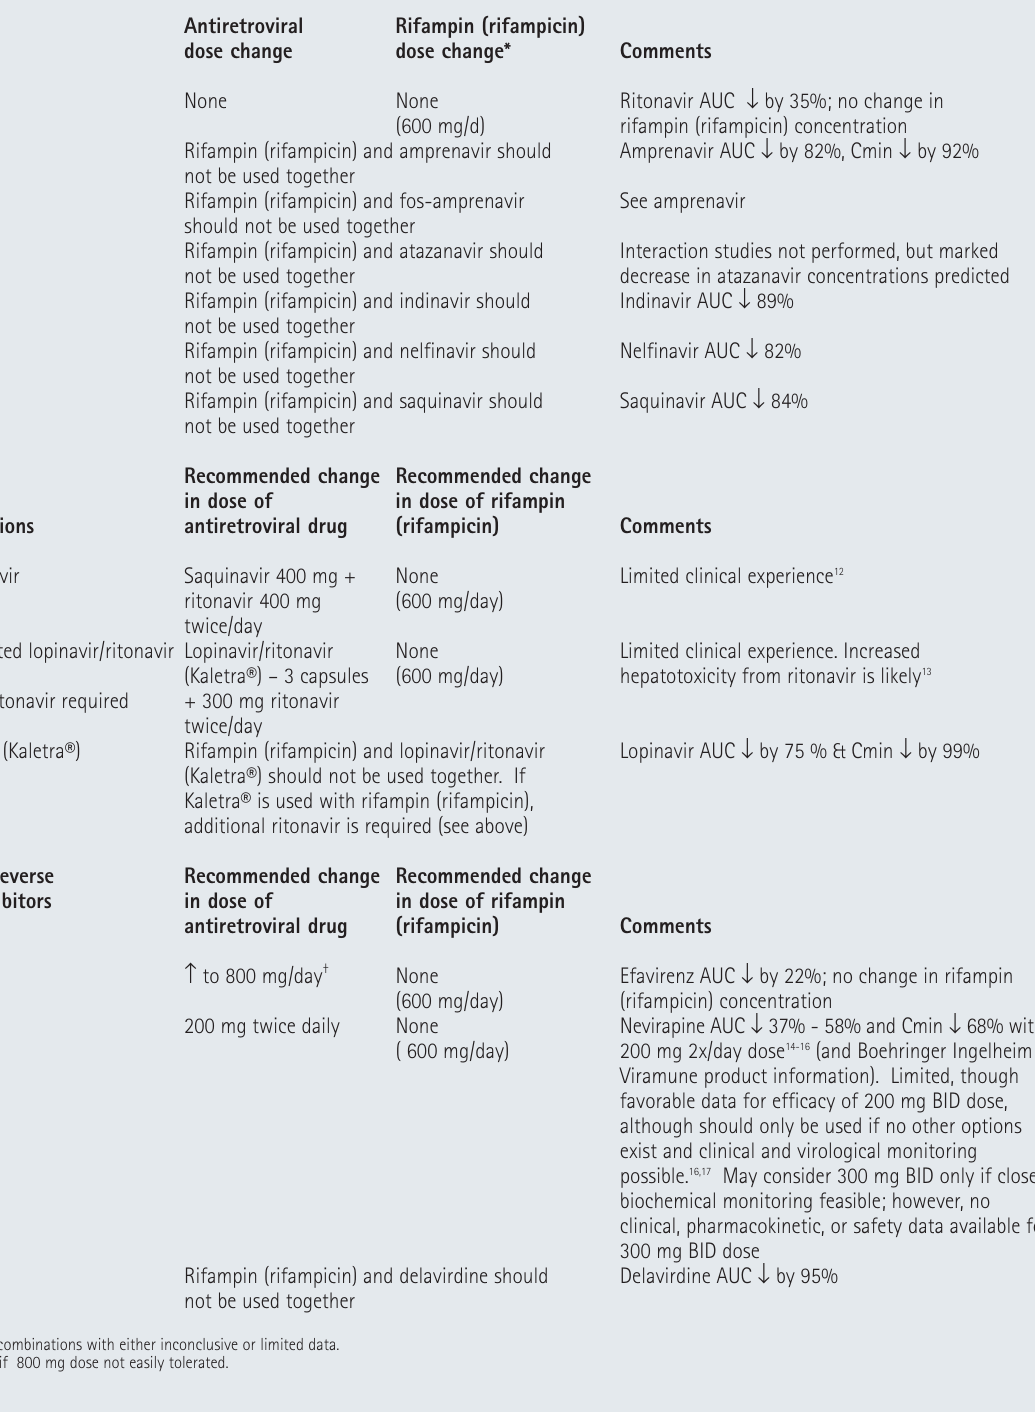
TABLE I. RECOMMENDATIONS FOR CO-ADMINISTERING PROTEASE INHIBITORS AND NON-NUCLEOSIDE REVERSE TRANSCRIPTASE INHIBITORS WITH RIFAMPIN (RIFAMPICIN) — UNITED STATES,